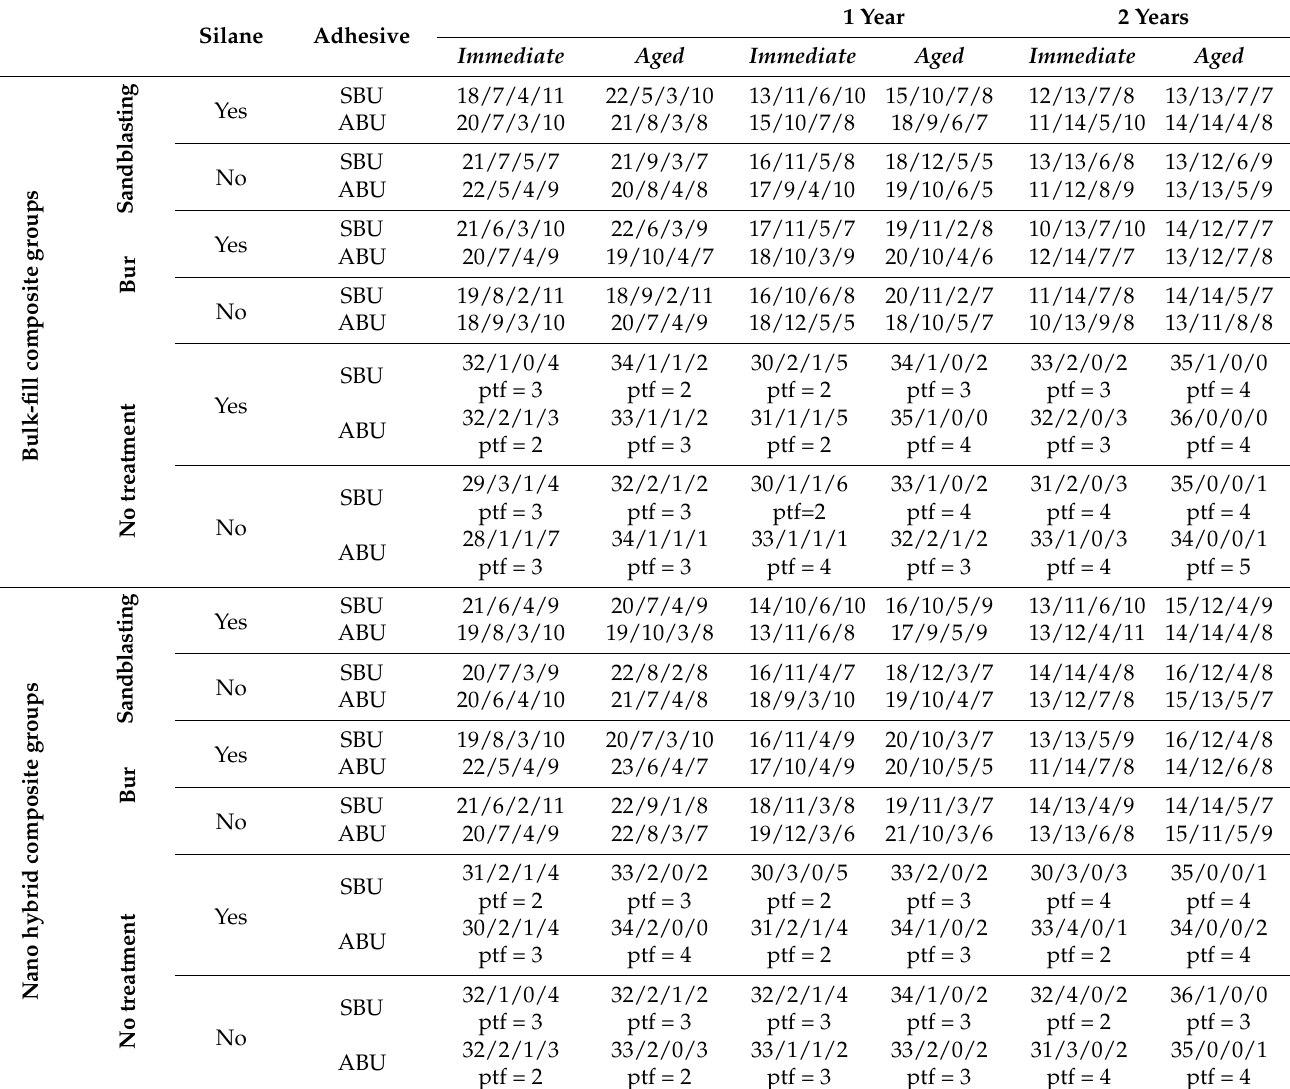
Table 5. The distribution of failure modes of the tested